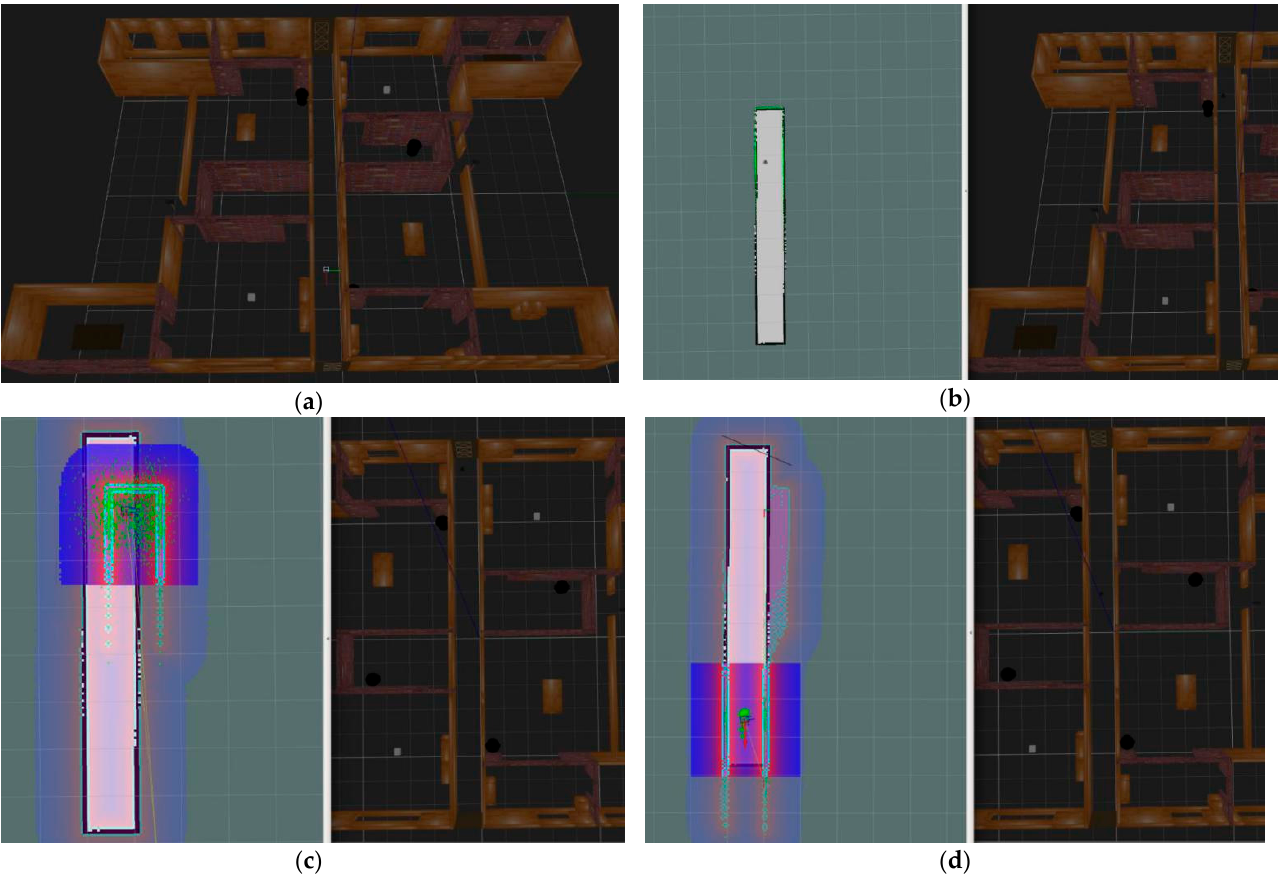
Figure 9. Turtlebot3_burger relocalization and navigation in a narrow hallway. ( a ) Simulation environment includes turtlebot3_burger and a narrow hallway. ( b ) Map of the hallway. ( c ) Robot initialization in the hallway map. ( d ) Navigation in the hallway map.